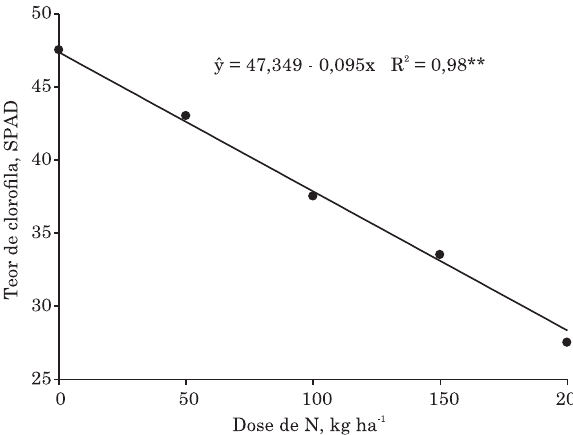
Figura 3. Doses de nitrogênio a serem aplicadas em cobertura a partir de leituras de clorofila (SPAD) das folhas de trigo, realizadas aos 38 dias após